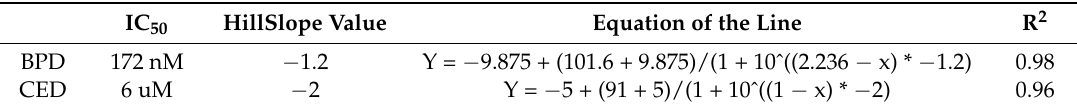
Table 3. IC 50 Values and Non-Linear Regression Analysis Results ( n = 3).